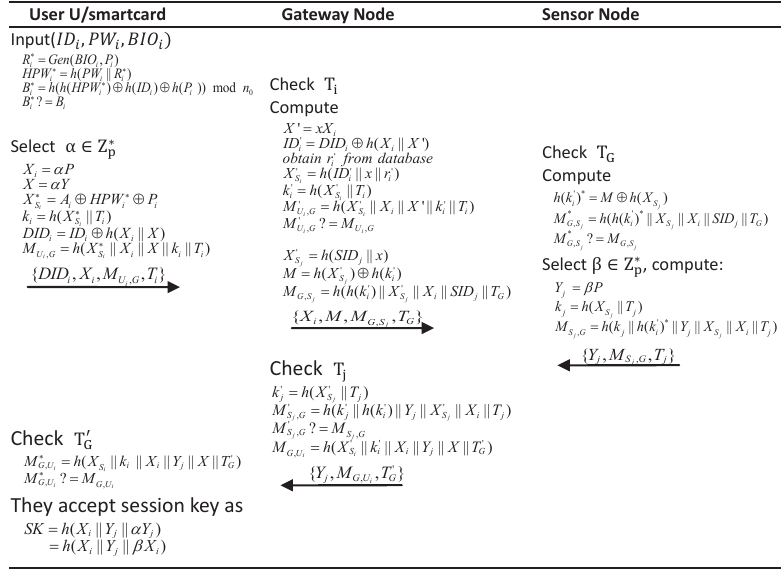
Figure 2. Proposed